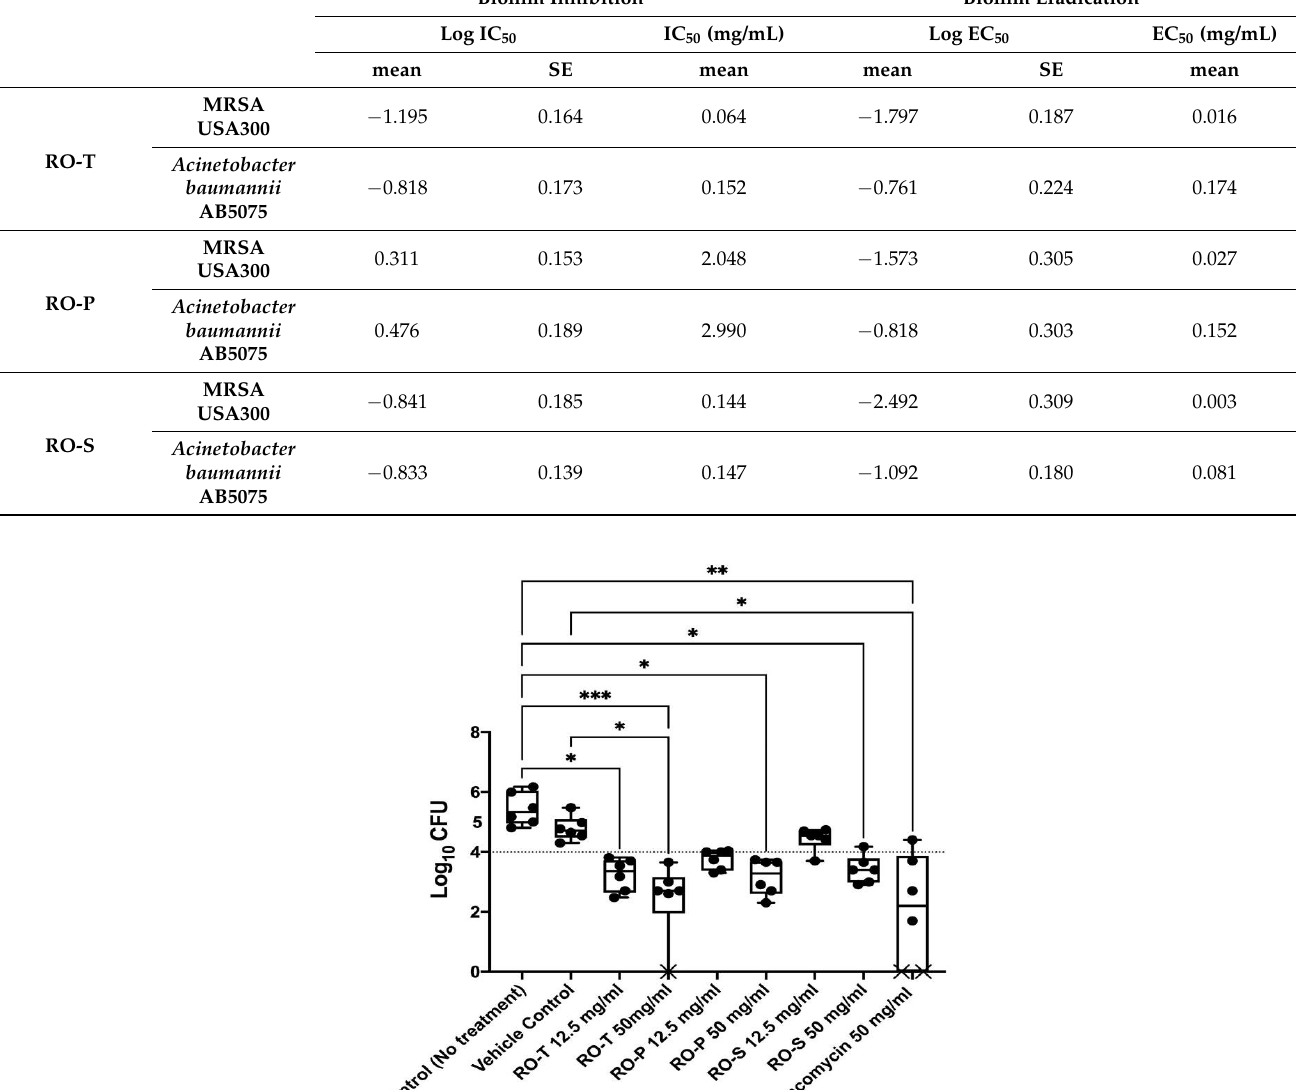
Table 2. The half maximal inhibitory/eradication concentration (IC50/EC50) of the tested extracts against biofilm of methicillin-resistant Staphylococcus aureus (MRSA USA300) and Acinetobacter bau- mannii AB5075. Biofilm Inhibition Biofilm